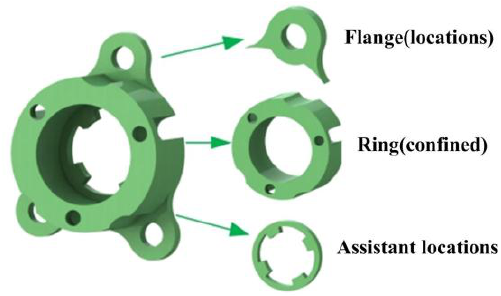
Figure 9. An example of parts disassembly.